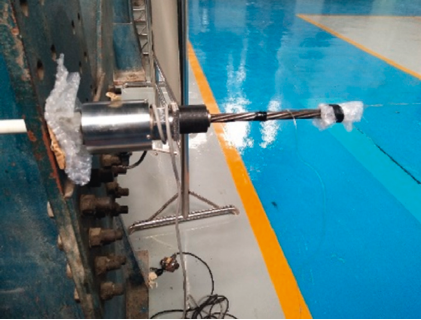
Figure 6: Diagram of anchorage, gaskets, and pressure sensor.